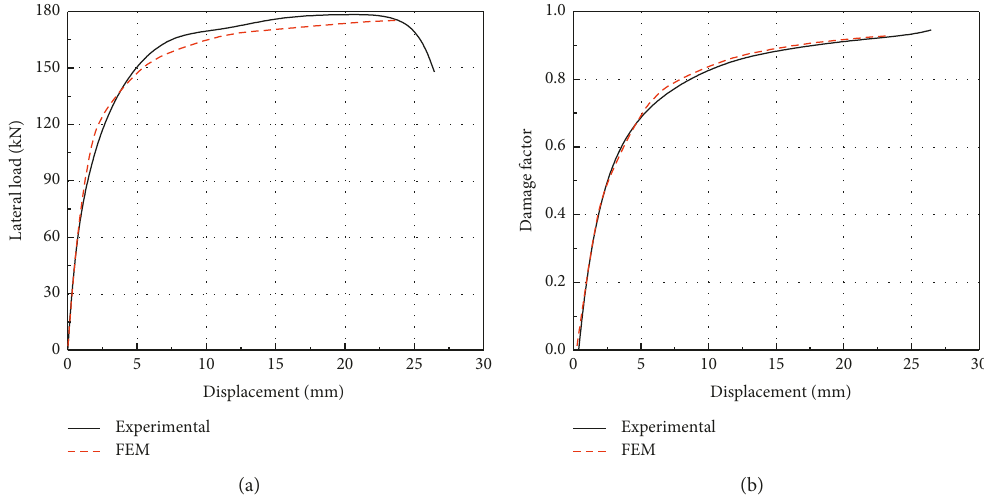
Figure 24: Experimental and FEM result comparison of SW2: (a) backbone curves and (b) damage factors.